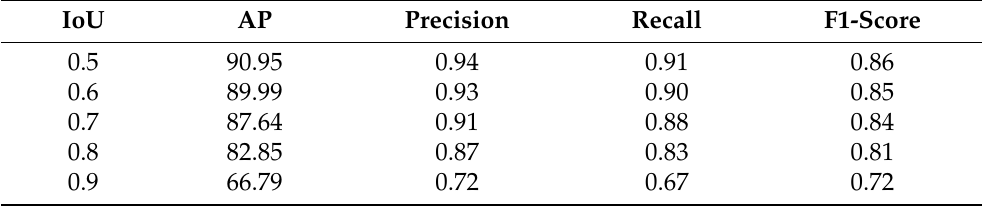
Table 3. The model performance results for Faster-RCNN+ConvNeXt+DyHead (bbox) on